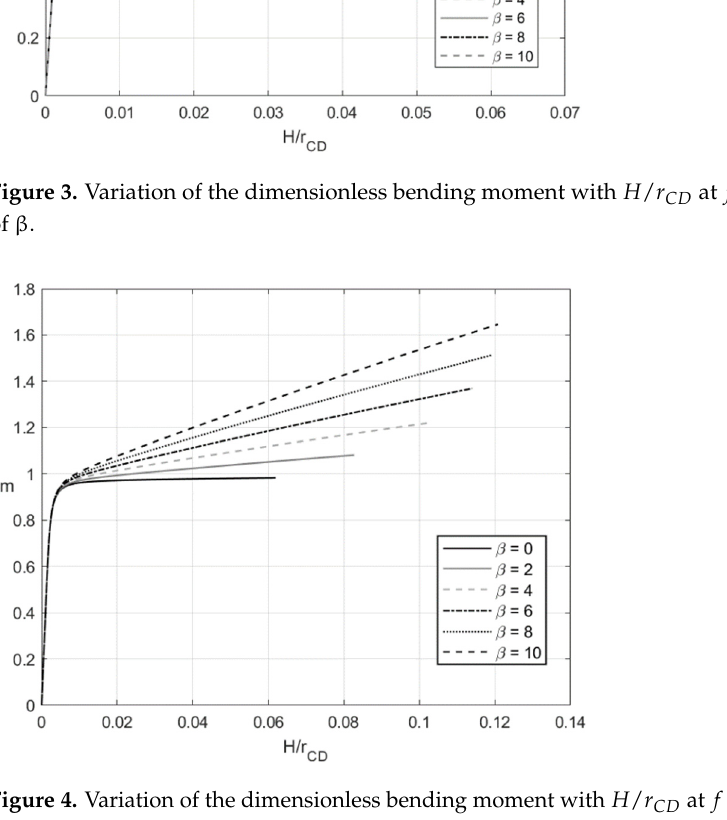
Figure 4. Variation of the dimensionless bending moment with H / r CD at f = 0.2 and several values of β .